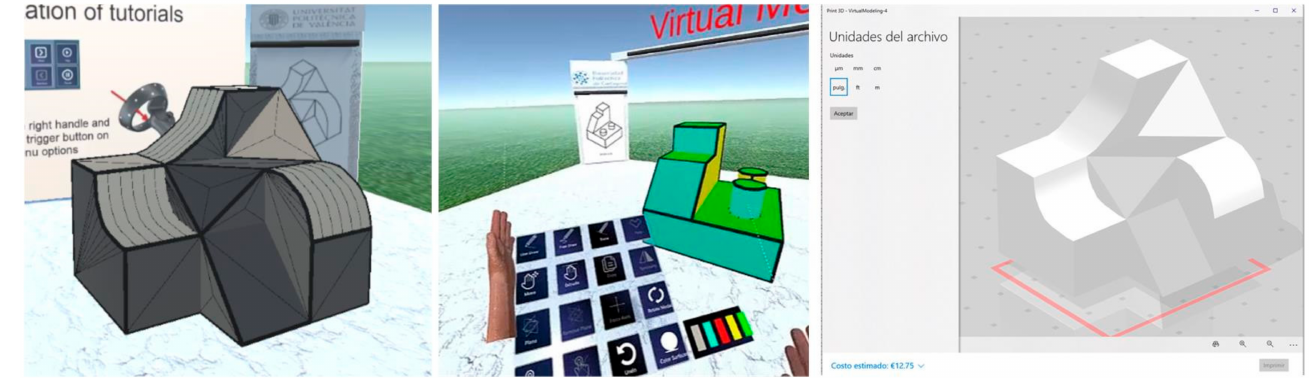
Figure 6. Model with secondary edges visible ( left ), surface coloring ( middle ), and exporting a model to STL ( right